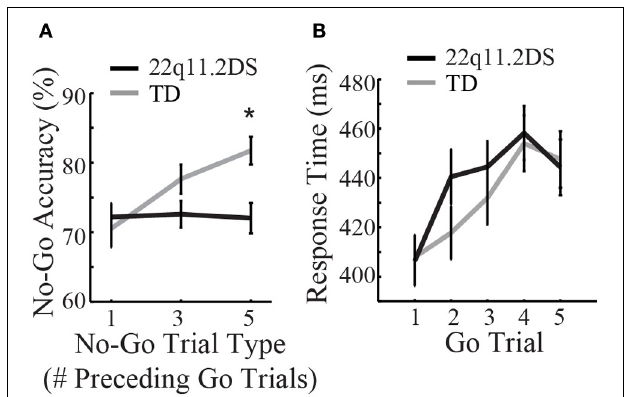
FIGURE 3 | Results of the response inhibition Go/No-Go task. (A) No-Go accuracy differed between groups ∗ p < 0 . 05, while (B) response time on Go trials was similar between groups.